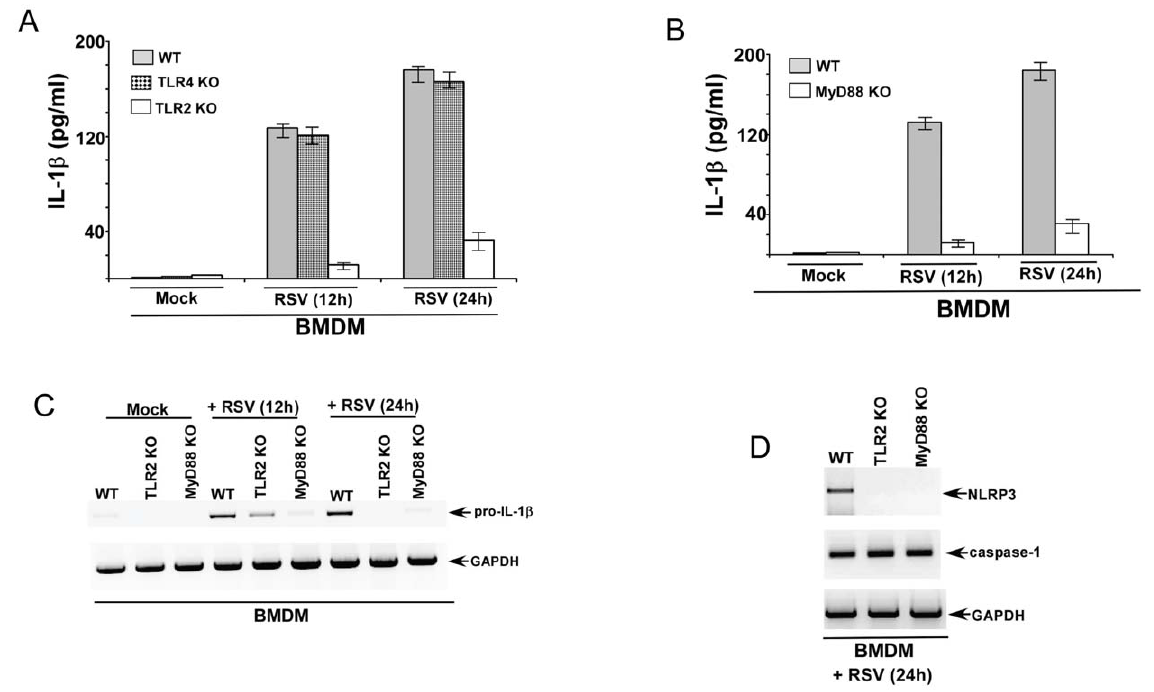
Figure 6. TLR2/MyD88 pathway is required for IL-1 b release during RSV infection. ( A ) Wild type (WT), TLR2 knock-out (KO) and TLR4 KO BMDMs were infected with RSV (1 MOI). IL-1 b levels in the medium supernatant were assayed by ELISA at 12 h and 24 h post-infection. ( B ) Wild type (WT) and MyD88 knock-out (KO) BMDMs were infected with RSV (1 MOI). IL-1 b levels in the medium supernatant were assayed by ELISA at 12 h and 24 h post-infection. ( C ) RT-PCR analysis of pro-IL-1 b expression in RSV infected WT, TLR2 KO and MyD88 KO BMDMs. (D) RT-PCR analysis of caspase-1 and NLRP3 expression in RSV infected WT, TLR2 KO and MyD88 KO BMDMs. The gels shown in (C) and (D) are representative of three independent experiments that yielded similar results. For ELISA assay, each value represents the mean 6 standard deviation from three independent